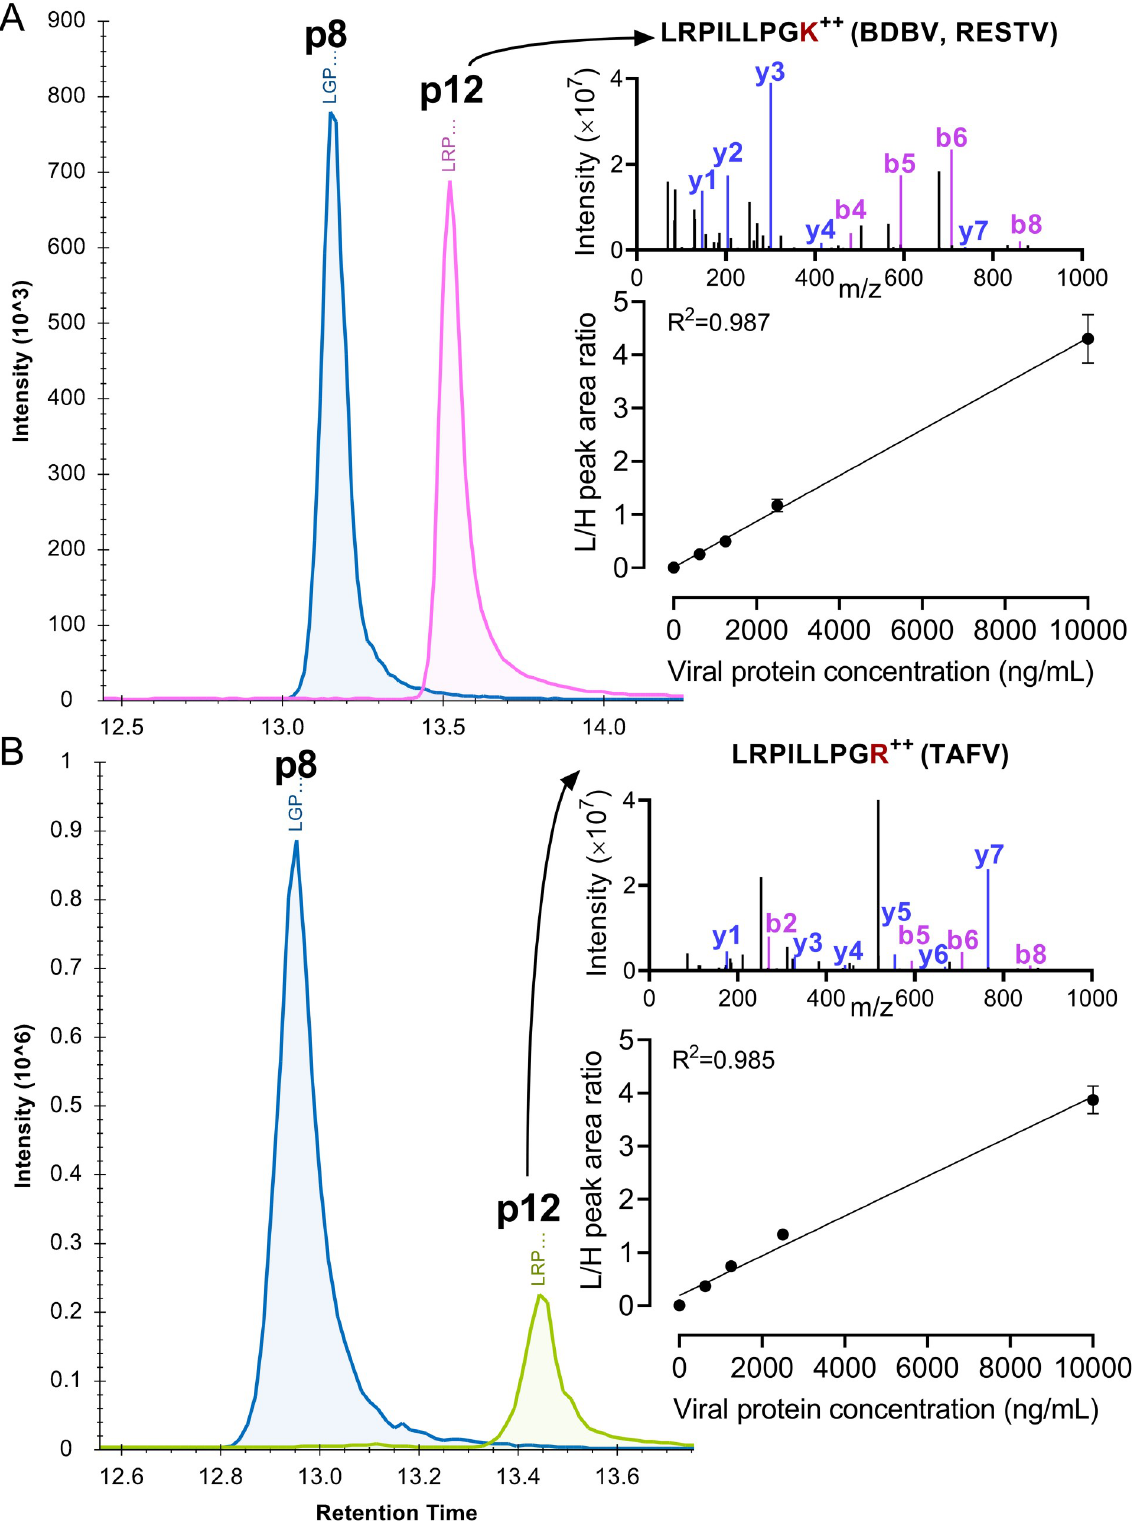
Fig 5. Method validation using inactivated virions from less lethal species. Extracted ion chromatograms of peptide 8 (blue line) and 12 (magenta and green lines) in the tryptic digest of (A) BDBV and (B) TAFV ebolavirus inactivated virions. The p8 sequence is shared by